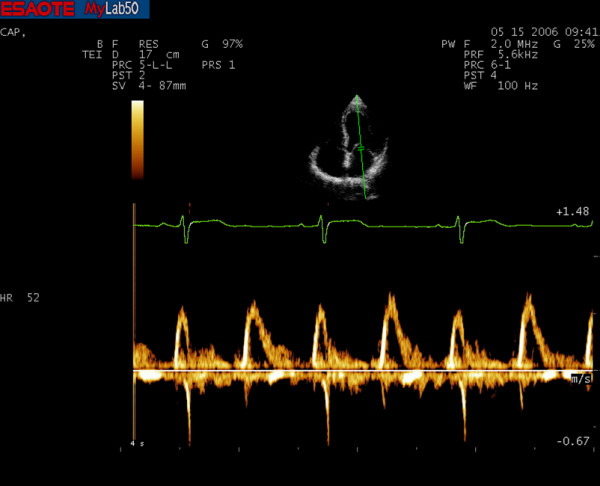
Conventional PW Doppler spectrum of a master athlete's heart.